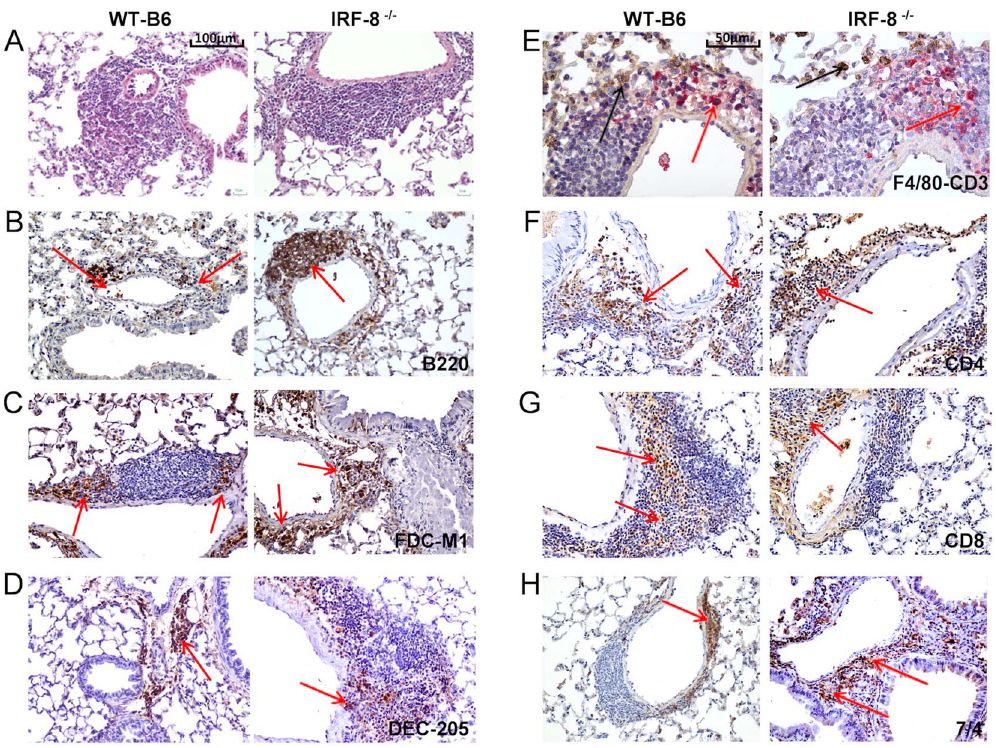
Figure 5. Formation of LS in the lungs of Mtb -infected IRF-8 2 / 2 vs. WT-B6 mice. IHC analysis of pulmonary sections from Mtb -infected mice at day 15 p.i. showing the distribution of immune cells in perivascular, peribronchial and interstitial areas of lung tissues. A) H&E staining (200X). B–D and F–H) Staining with the indicated mAbs (brown). Red arrows depict marker-positive cells. E) Co-staining with anti-F4/80 (brown) and anti-CD3 (red) mAbs, depicted by black and red arrows respectively. Representative slides are shown, all taken at 200X magnification, except for (E) taken at 400X magnification. Three independent experiments were performed. (Fig. 5E). We found a comparable infiltration of CD3 + T lymphocytes, both CD4 + and CD8 + T cells, as well as similar levels of F4/80 + macrophages in the areas surrounding vessels and bronchial tree in both IRF-8 2 / 2 and WT-B6 lungs (Fig. 5E, F, G). In addition, DEC205 + DC accumulated at similar frequencies in areas surrounding pulmonary vessels and bronchi of both strains of mice (Fig. 5D). In contrast, higher numbers of 7/4 + neutrophils aggregates were found in LS of IRF-8 2 / 2 mice compared to controls (Fig. 5H). Of interest, while the areas surrounding the